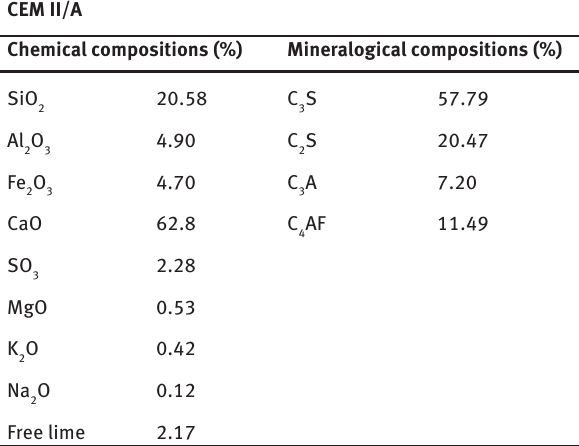
Table 2: Chemical and mineralogical compositions of the cement.